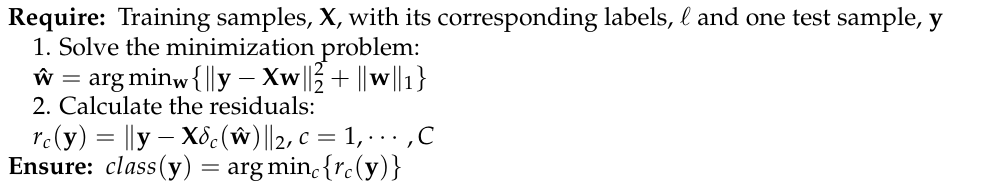
Algorithm 1 Basic sparse representation classification